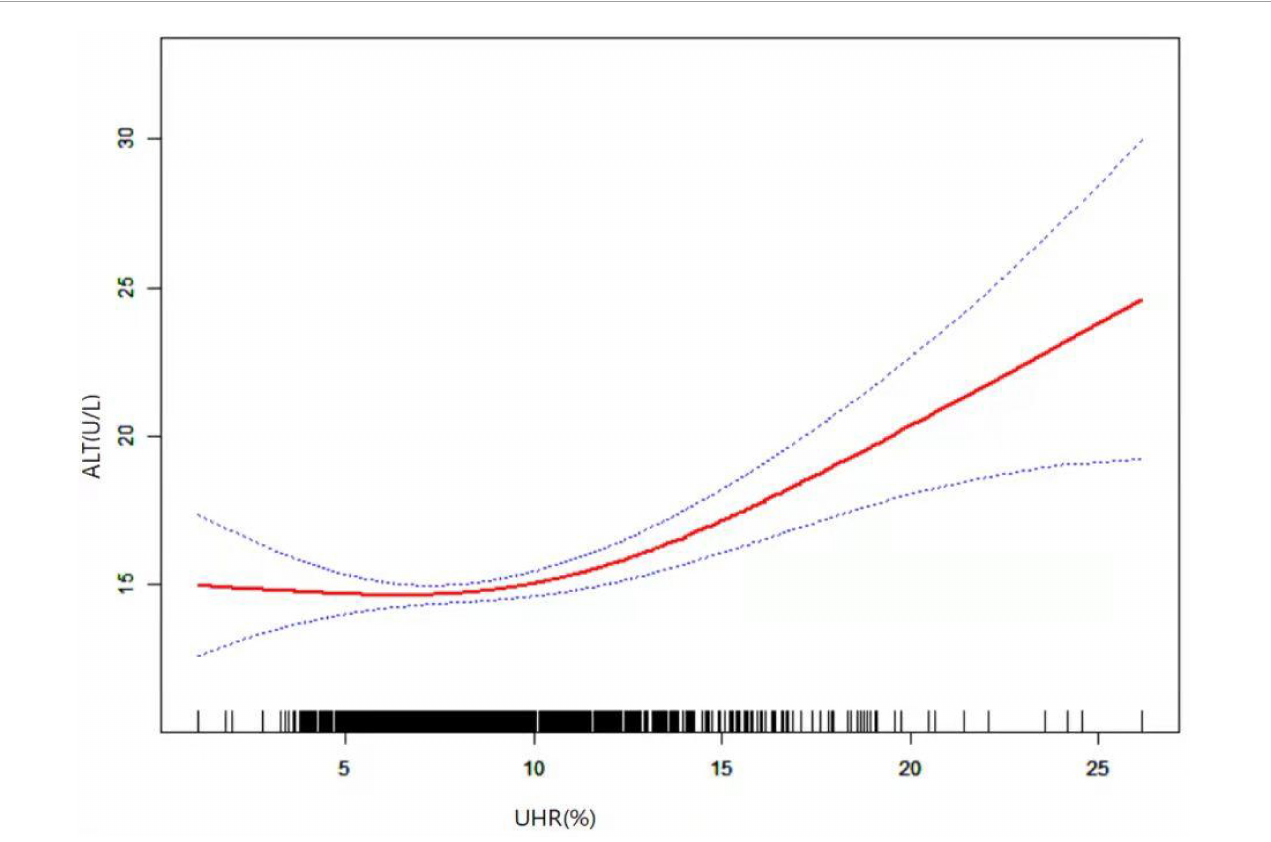
FIGURE1 Relationship between UHR and ALT by smooth curve fitting. Adjustment variables: sex, age, puberty stage, BMI, SBP, DBP, and GH peak. BMI, body mass index; SBP, systolic blood pressure; DBP, diastolic blood pressure; GH peak, growth hormone peak; UHR, uric acid to high density lipoprotein cholesterol ratio; ALT, alanine